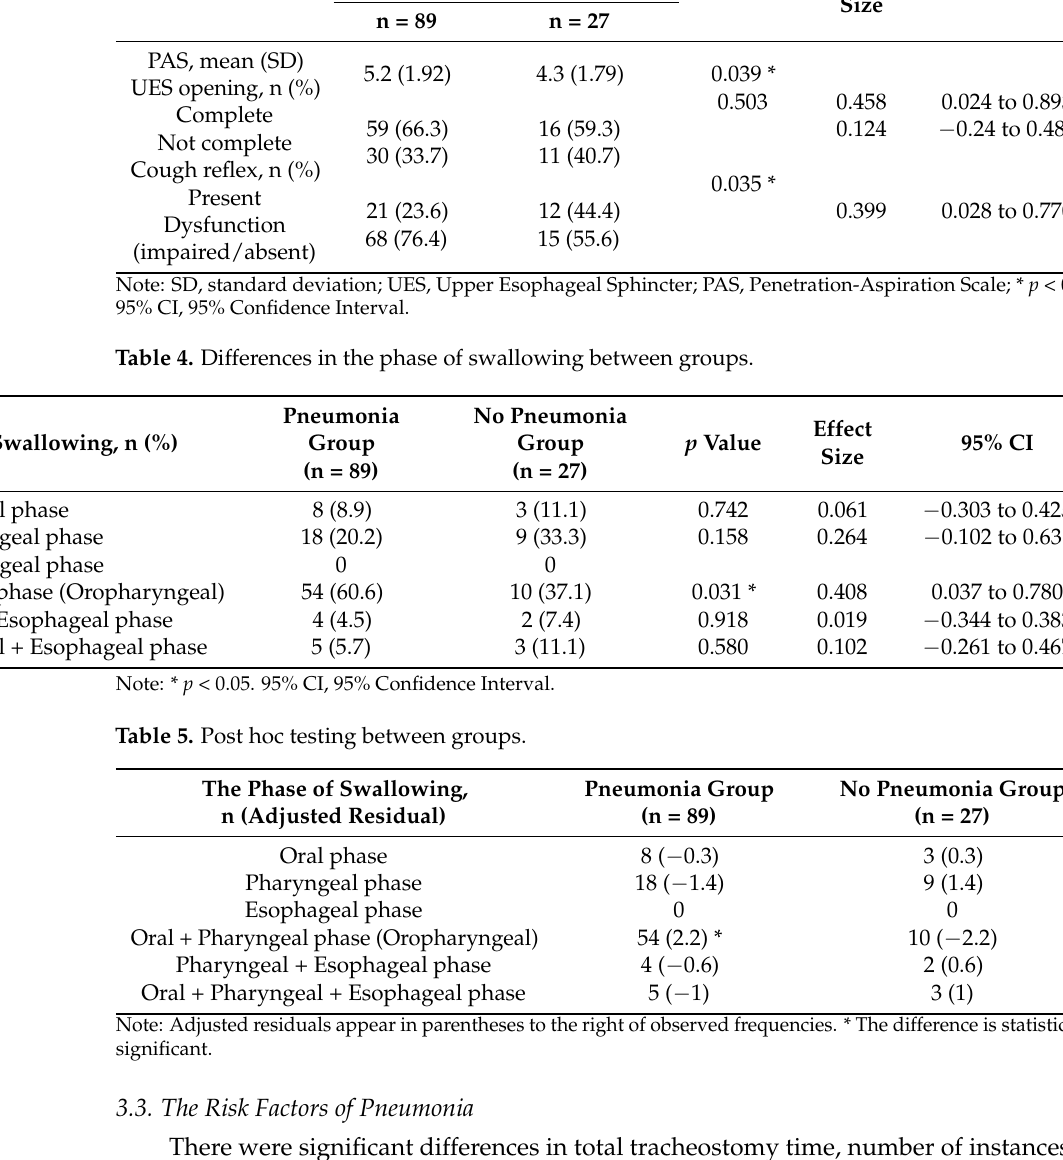
Table 3. Analysis of swallowing function on pneumonia. Pneumonia Variables